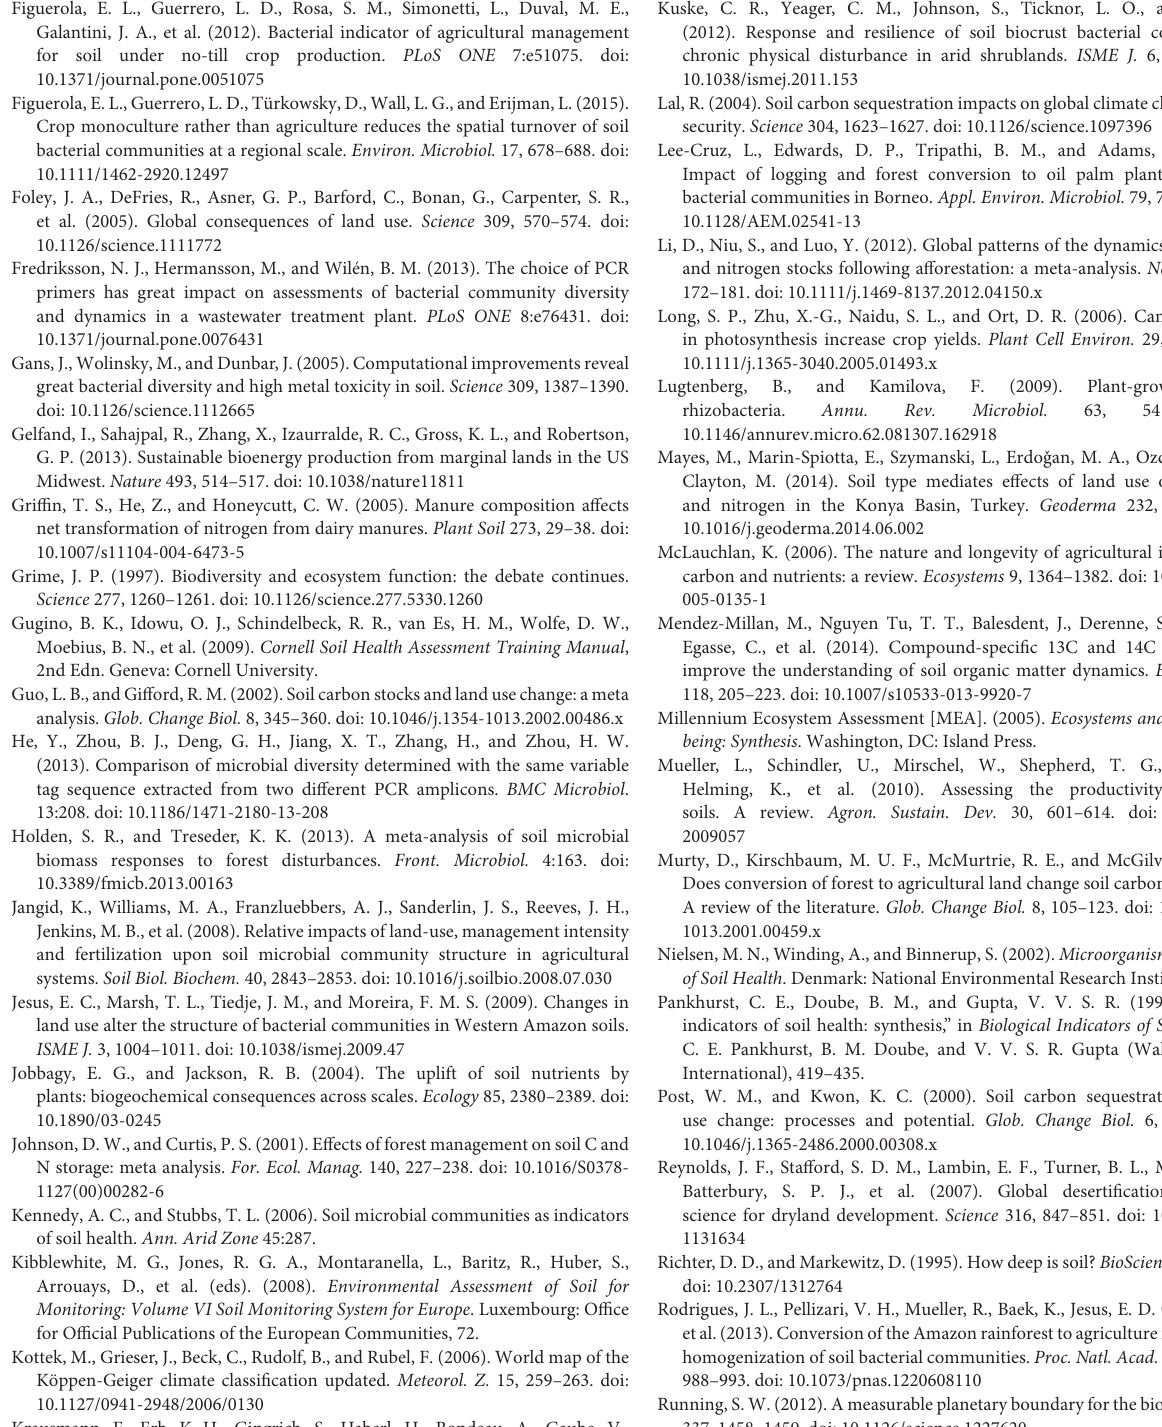
Figuerola, E. L., Guerrero, L. D., Rosa, S. M., Simonetti, L., Duval, M. E., Galantini, J. A., et al. (2012). Bacterial indicator of agricultural management for soil under no-till crop production. PLoS ONE 7:e51075. doi: 10.1371/journal.pone.0051075 Figuerola,E.L.,Guerrero,L.D.,Türkowsky,D.,Wall,L.G.,andErijman,L.(2015). Crop monoculture rather than agriculture reduces the spatial turnover of